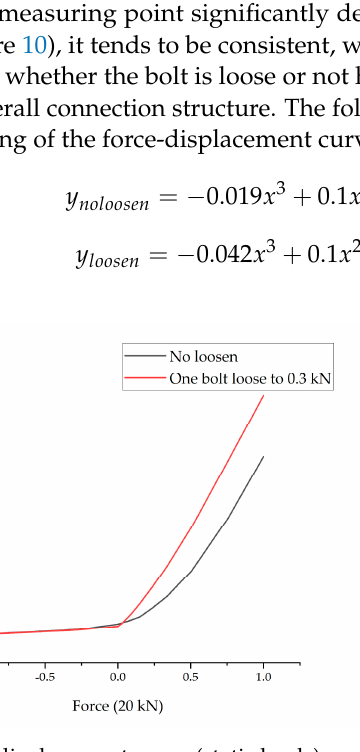
Figure 9. Acceleration response (varies with mesh size).